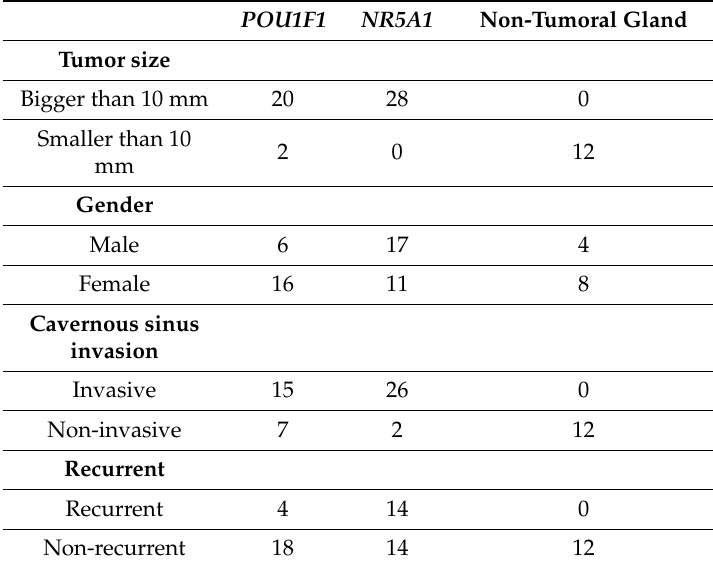
Table 1. Clinical features of patients with POU1F1 - and NR5A1 derived pituitary adenomas.